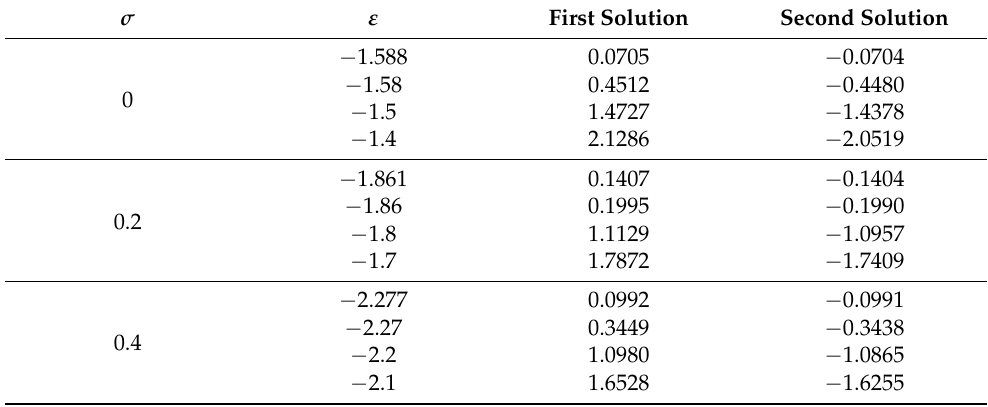
Table 2. Smallest eigenvalues λ for several values of ε with different σ and δ for fixed ϕ = 0.1.